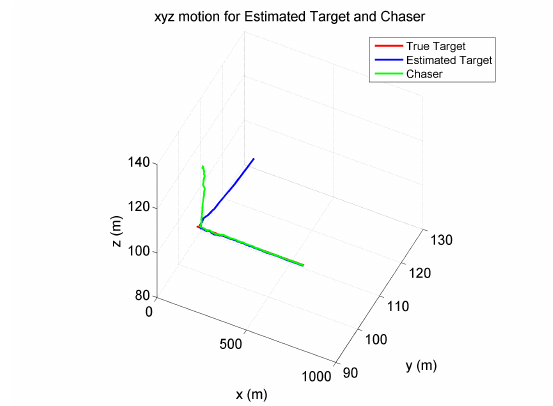
Figure 6. Chaser trajectory while tracking the estimated target (Case 1A).